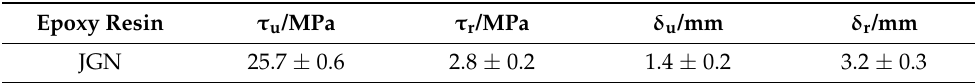
Table 2. Parameters of the bond-slip model.